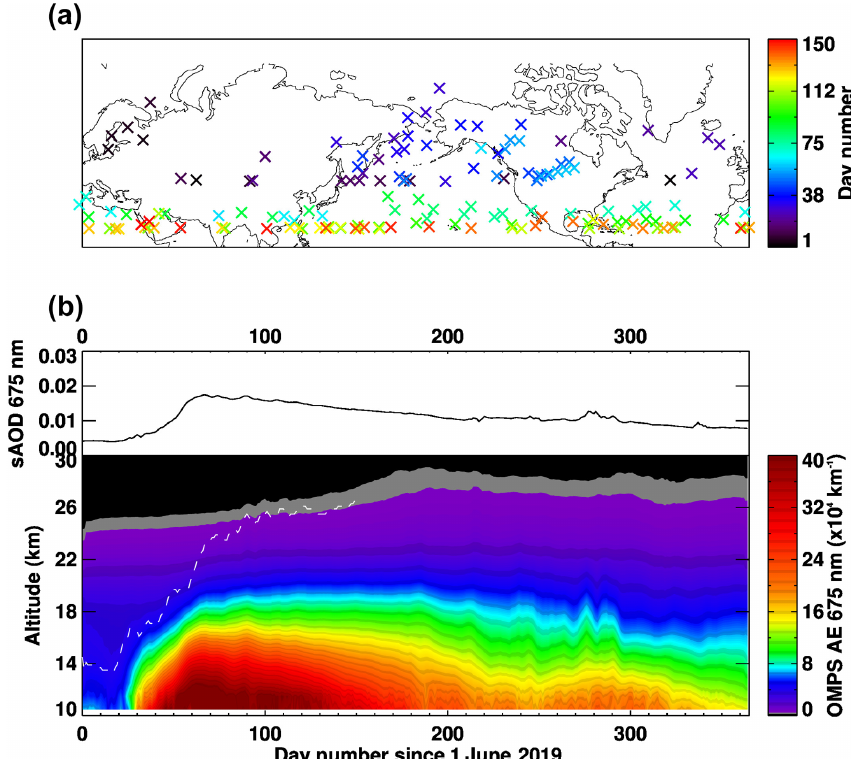
Figure 9. (a) Daily location of the maximum altitude reached by the Raikoke aerosol plume as detected by OMPS LP, colored by the day number since 1 June and plotted every other day until day 150. (b) Daily zonal mean aerosol extinction profiles at 675nm (km − 1 ) between 20 ◦ S–90 ◦ N (which is close to hemispheric coverage) measured by OMPS LP from June 2019 to June 2020 and smoothed spatially using a five-point boxcar averaging. Only profiles measured above tropopause + 1km are used. The white line is the aerosol plume maximum altitude in kilometers (km). (b) (Top) Stratospheric aerosol optical depth ( × 10 3 , sAOD) at 675nm, derived by integrating aerosol extinction profiles above the tropopause to